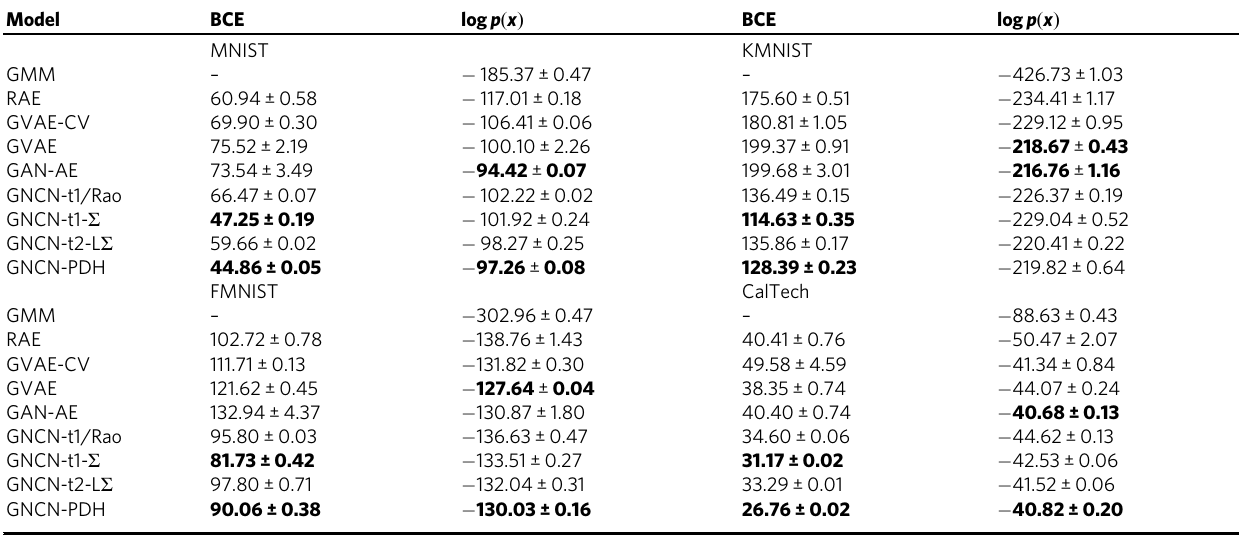
Table 1 Reconstruction and likelihood measurements: Generative modeling results across